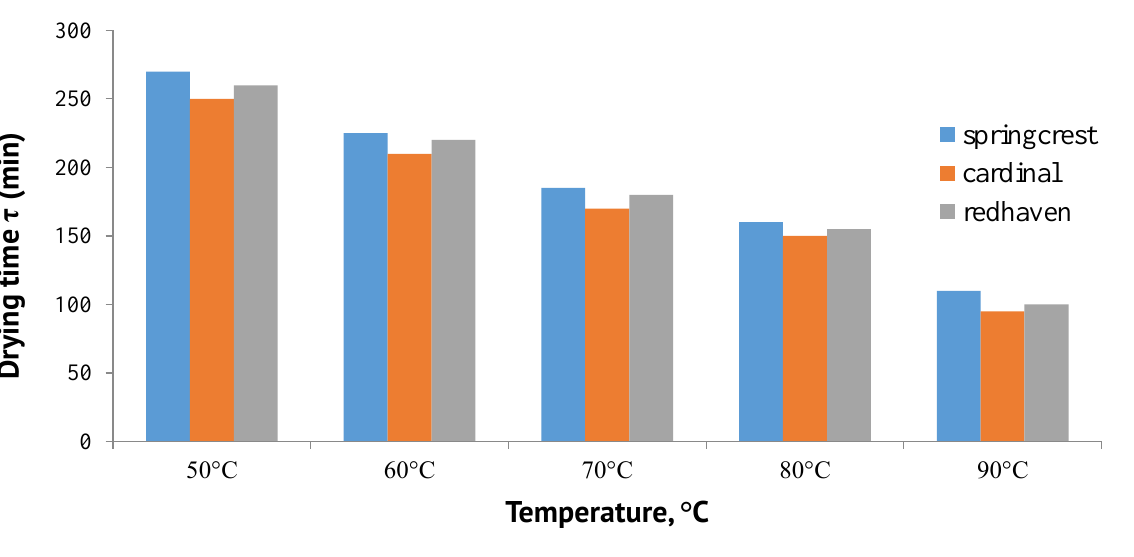
Figure 11. Correlation between peaches variety and drying time ( τ = f